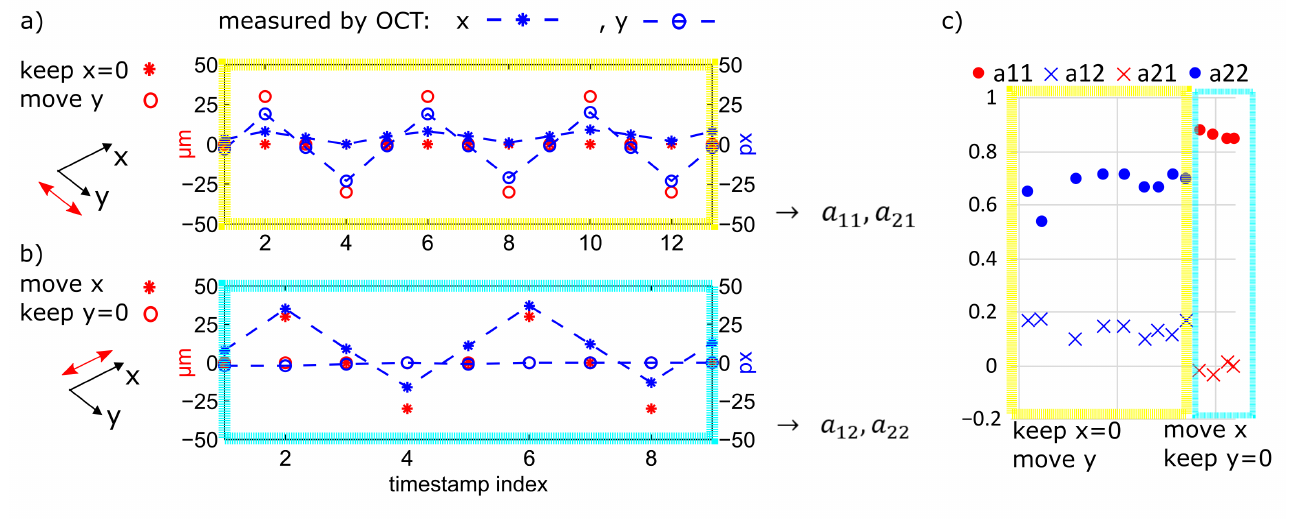
Figure 12. Translation calibration. ( a ) Here, x is held constant, and the y axis moves back and forth between two positions. The OCT sensor detects the y movement but also a parasitic movement in the x direction (blue asterisk line). ( b ) Here, y is held constant, and the x axis moves back and forth between two positions. The OCT image detected a slow drift in the x direction. The time between two measurement points was one minute. ( c ) Drift-corrected result of the matrix elements. The average of the results proved to be a sufficiently exact